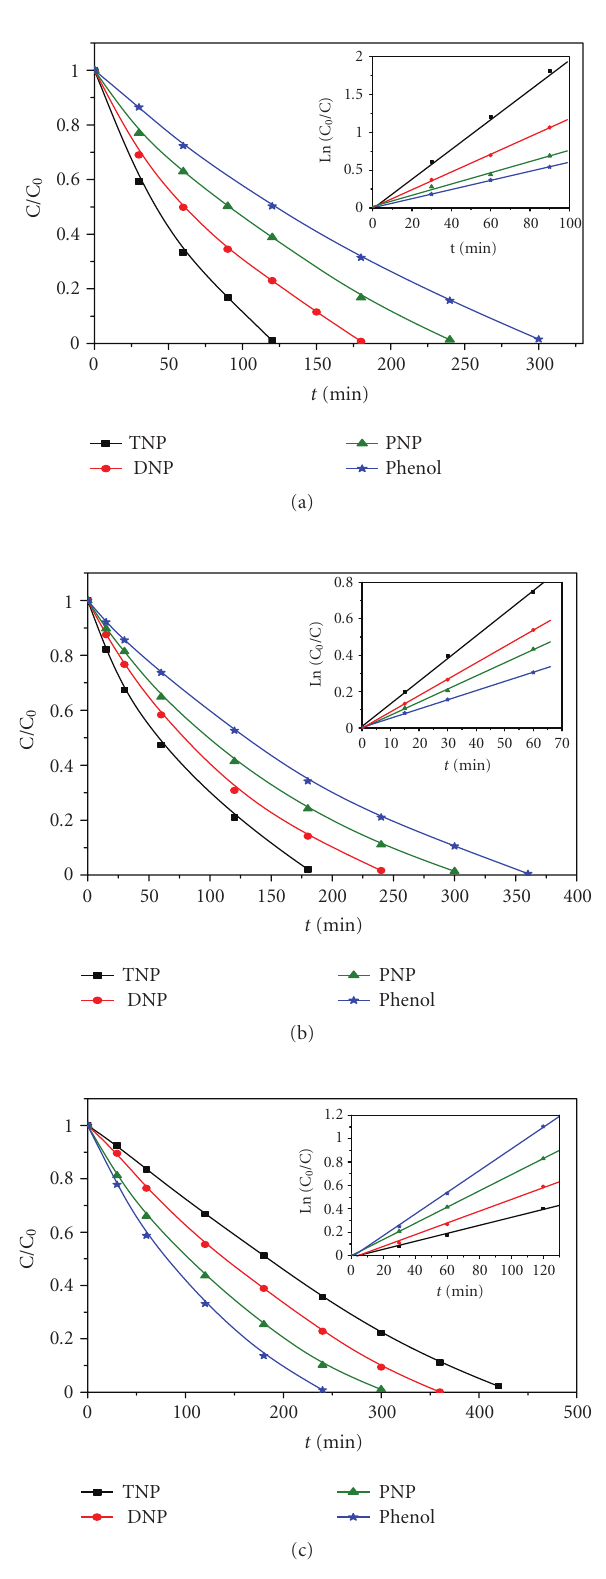
Figure 4: Kinetics of the photocatalytic degradation of phenols in presence of di ff erent catalysis ((a) P25, (b) PC500, and (c) sup- ported TiO 2 (paper 1048)). In the insert, first-order linear trans- forms Ln C 0 /C = f ( t ). Experimental conditions: C 0 = 30 mg/L, [P25] = [PC500] = 0.5 g/L, V = 1L, natural pH.